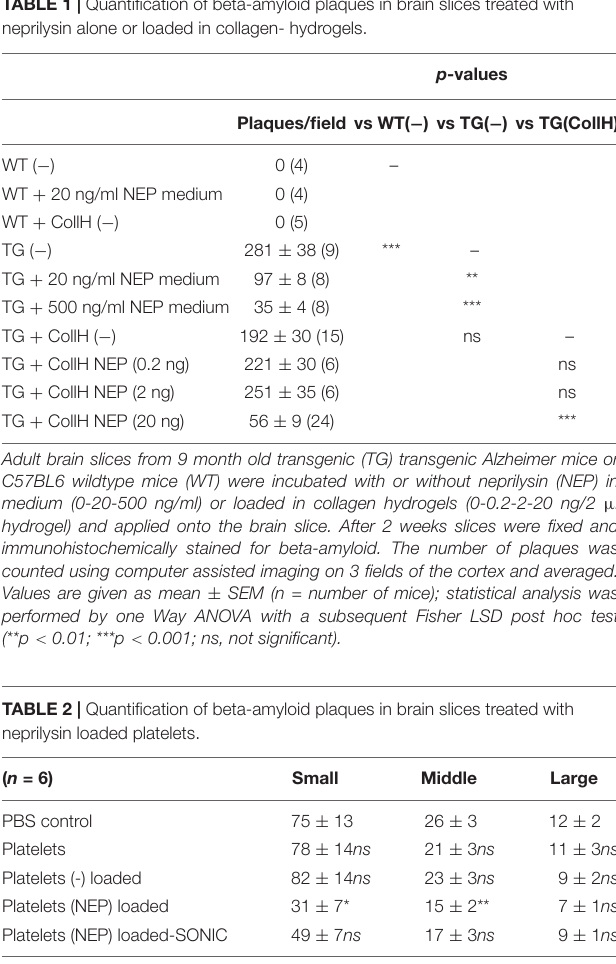
TABLE 1 | Quantification of beta-amyloid plaques in brain slices treated with neprilysin alone or loaded in collagen- hydrogels.